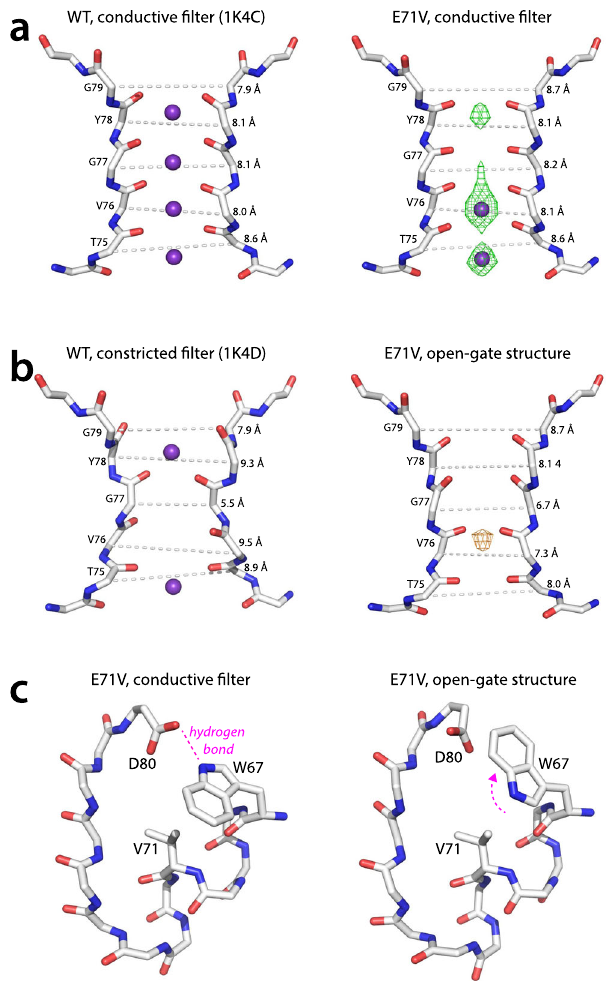
Fig. 2 X-ray structures of WT and E71V KcsA. a The conductive selectivity fi lters of WT and E71V KcsA, both with closed lower gates. b Comparison of the constricted selectivity fi lter of WT KcsA (with a closed lower gate) and the narrowed selectivity fi lter of the open-gate structure of E71V KcsA. Both structures were obtained in the absence of K + . The C α -C α distances between residues of opposing protomers are shown. The closed-state and open-state E71V KcsA structures were obtained with 5 mM and 0 mM K + , respectively. The green mesh shows the difference density map, the orange mesh the anomalous density. The difference (green) map is for the K + ions and contoured at 8 σ . The orange density map (anomalous) is contoured at 5 σ . An ion cannot be clearly assigned to the density due to the weak signal. c The W67 sidechain fl ips in the E71V open-state structure, breaking the hydrogen bond with the D80 sidechain that is important for inactivation in Kv channels 12,19,44,45